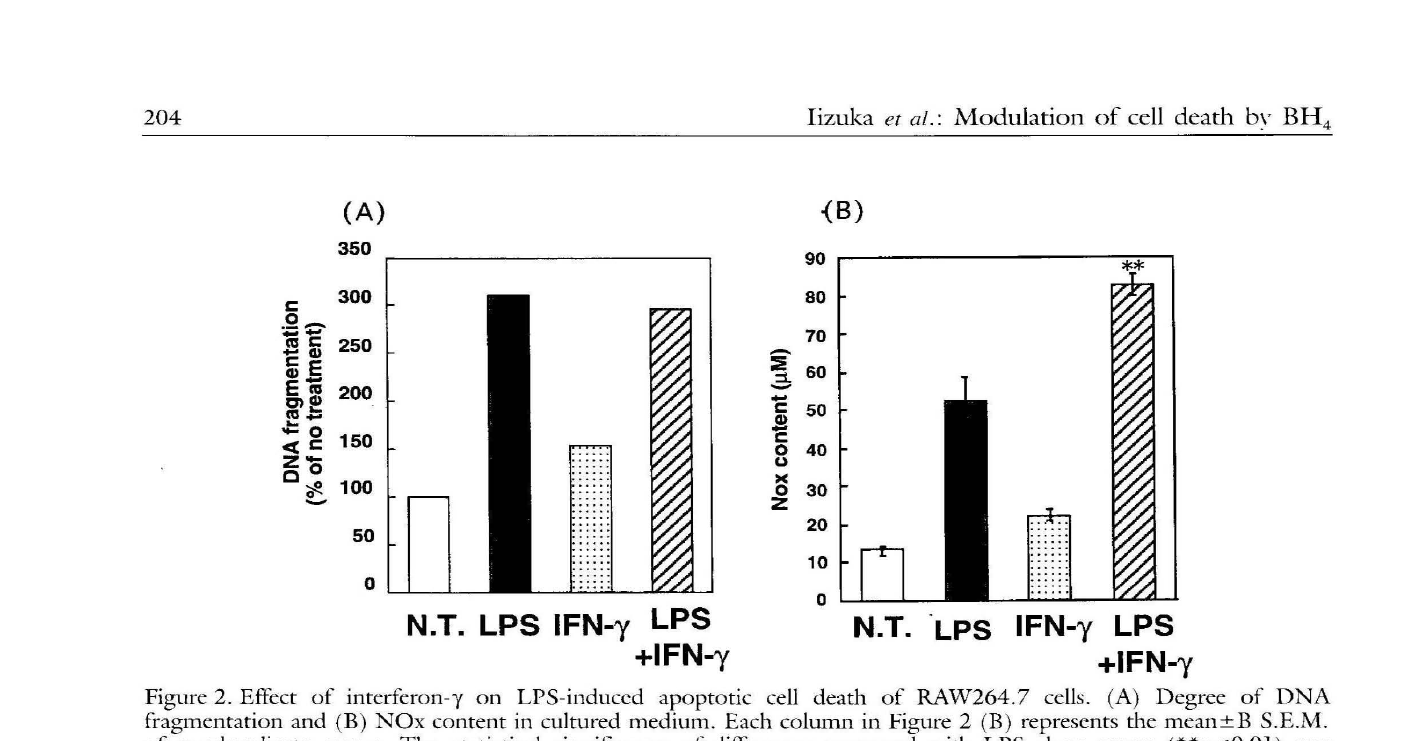
Figure 2. Effect of interferon-yon LPS-induced apoptotic cell death of RAW264.7 cells. (A) Degree of DNA fragmentation and (B) NOx content in cultured medium. Each column in Figure 2 (B) represents the mean±B S.E.M. of quadruplicate assays. The statistical significance of differences compared with LPS alone group (**p<O.Ol) was determined by means of Student's t-test. N.T., no treatment; LPS, lipopolysaccharide (1 Ilg/ml); IFN-y, interferon-y (100 D/ml); LPS+IFN-y, lipopolysaccharide (1 Ilg/ml) plus interferon-y (100 v /ml).